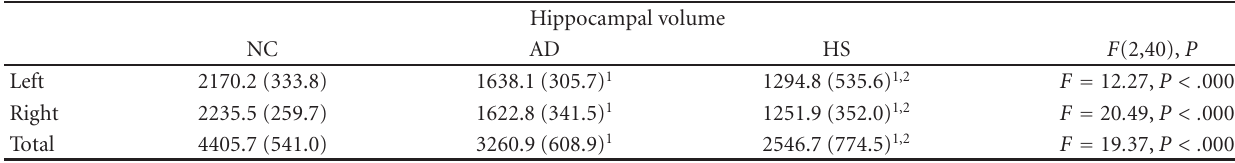
Table 5: Left, right, and total hippocampal volumes in NC, AD, and